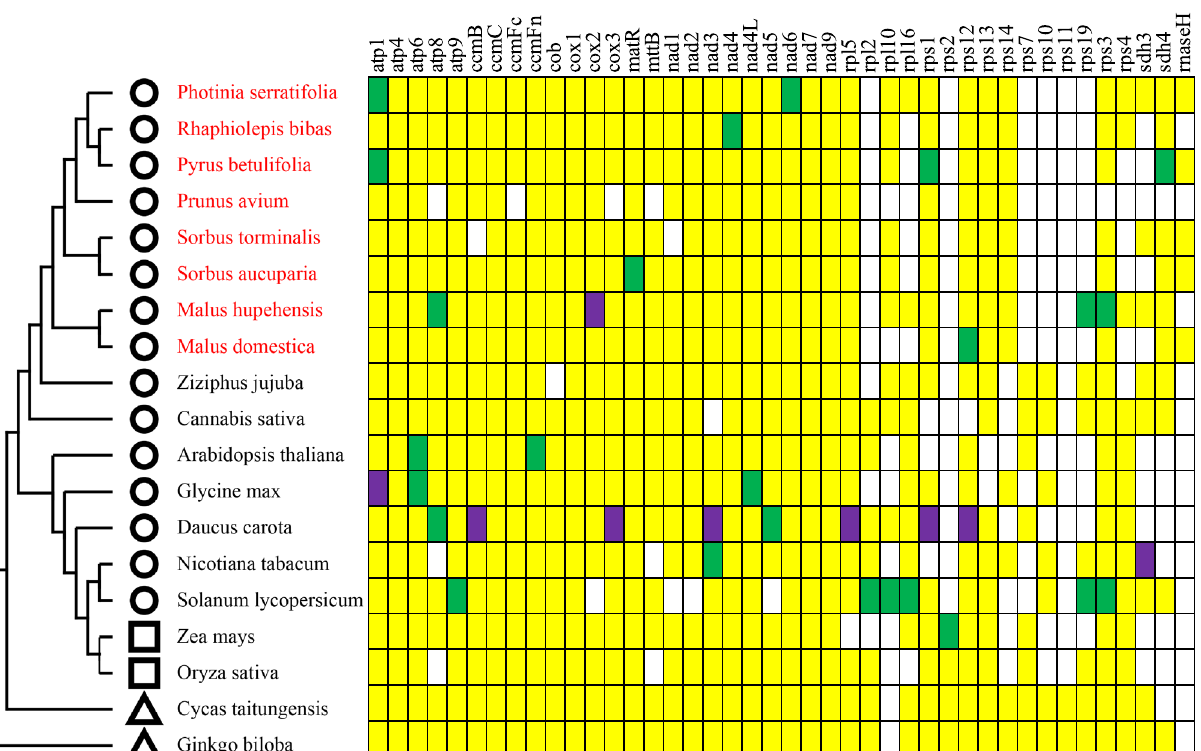
Figure 2. Distribution of protein-coding genes in plant mitogenomes. Yellow, green, and purple boxes indicate that one, two, and three copies exist in the plant mitogenome, respectively. White boxes indicate that the gene is missing in the plant mitogenome. The circles, squares, and triangles represent dicots, monocots, and gymnosperms, respectively. Besides, the red-colored plant names are species from the Rosaceae family.